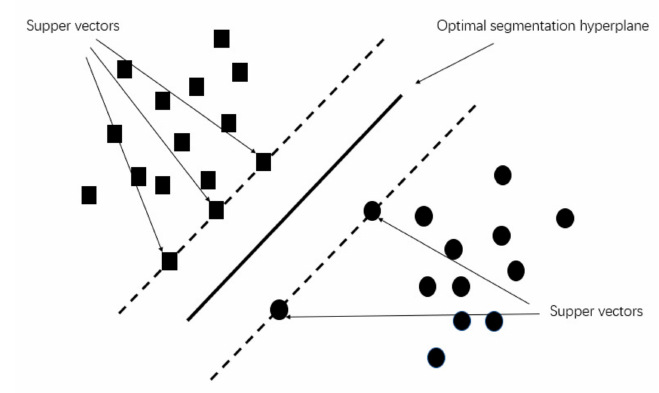
Figure 5. Schematic diagram of